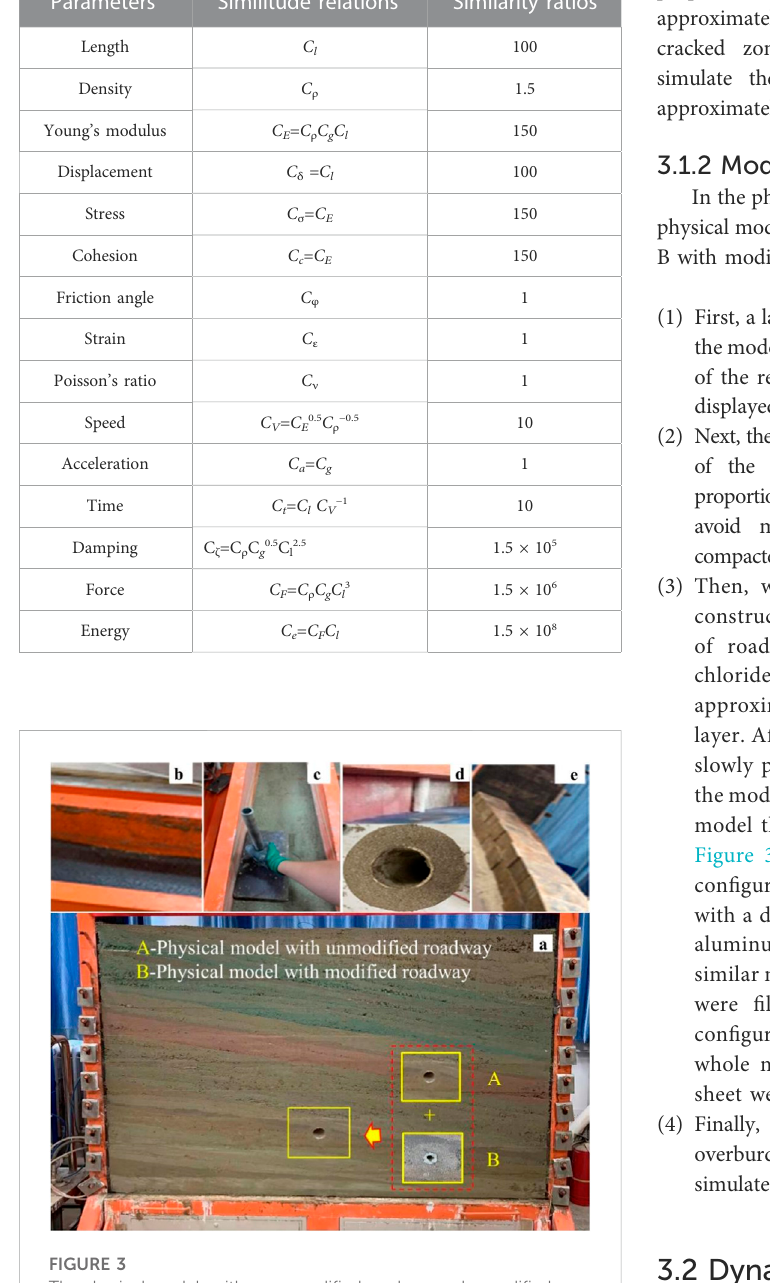
TABLE 2 The similarity coef fi cient for the physical model experiments. Parameters Similitude relations Similarity ratios